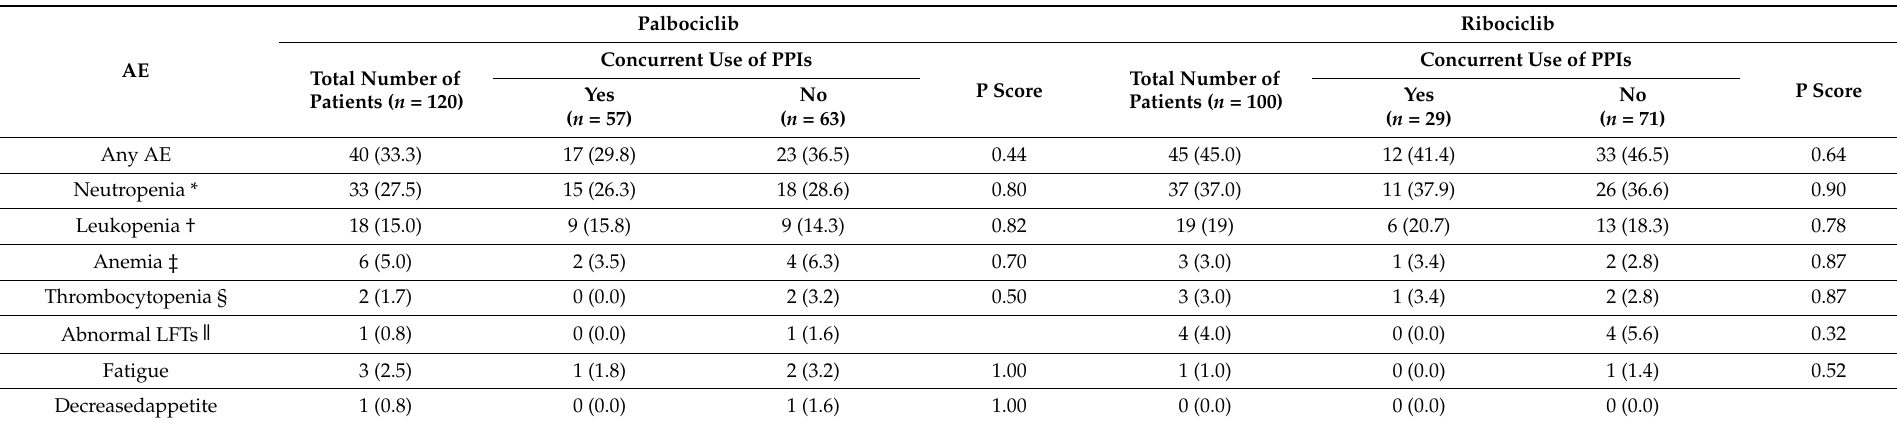
Table 3. Grade 3–4 adverse events.